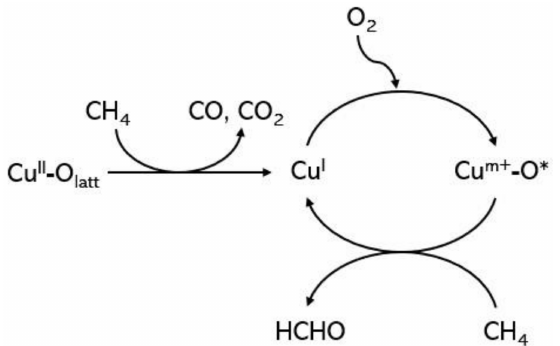
Figure 9. Reaction mechanism for selective oxidation of CH 4 to HCHO over the CuO x /SBA-15 catalyst [35]. Copyright 2008, with permission from American Chemical